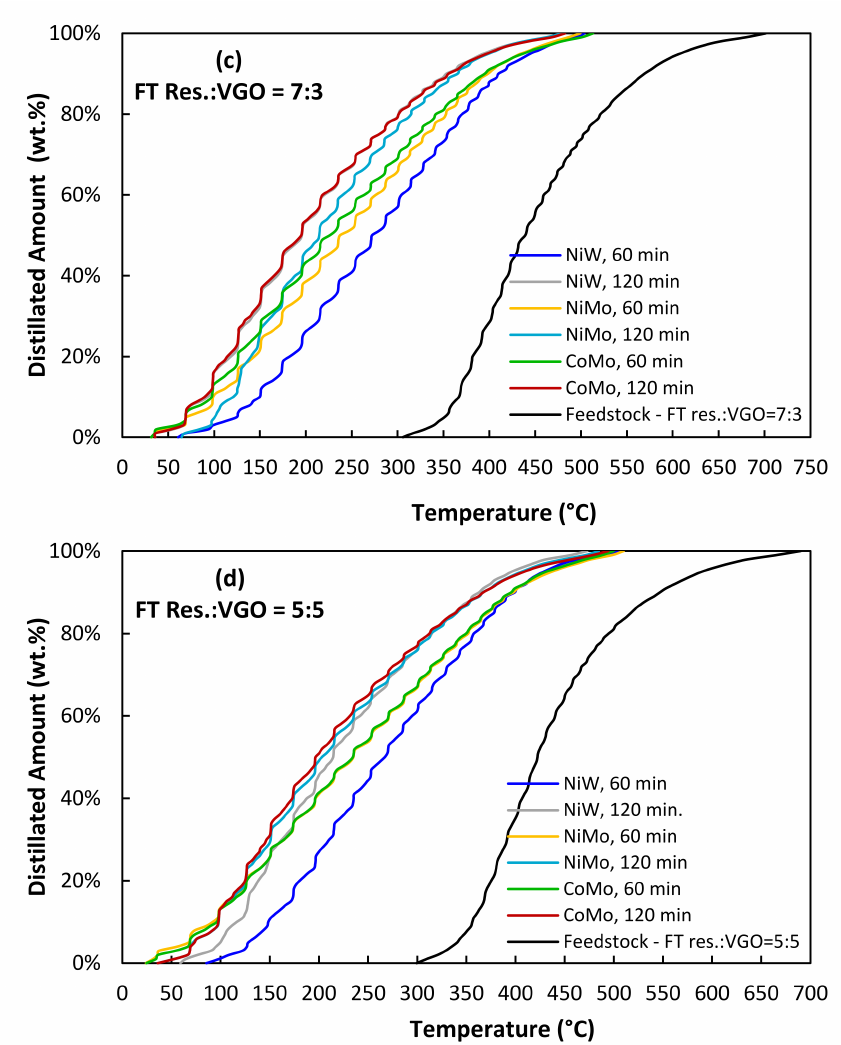
Figure 1. SIMDIS analysis of the feedstock and the products after hydrocracking reaction at different reaction conditions and different catalysts with different feedstock compositions: ( a ) FT residue, ( b ) FT Res.:VGO = 9:1, ( c ) FT Res.:VGO = 7:3, ( d ) FT Res.:VGO =